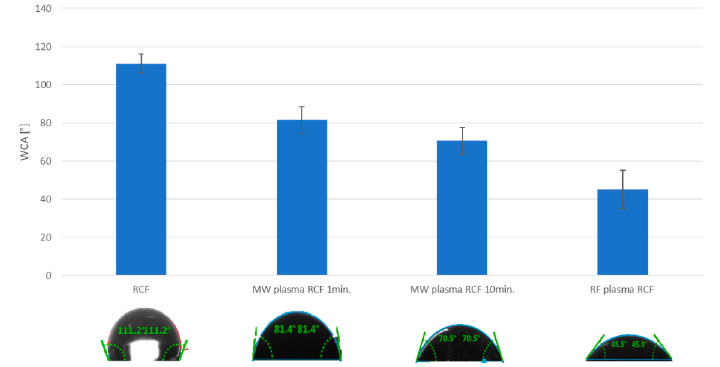
Figure 7. Measurement of wettability of RCF.